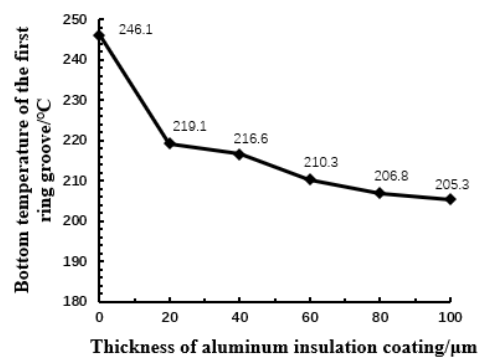
Fig. 9. The change of the average temperature of the first ring groove with the AlCrN coating thickness